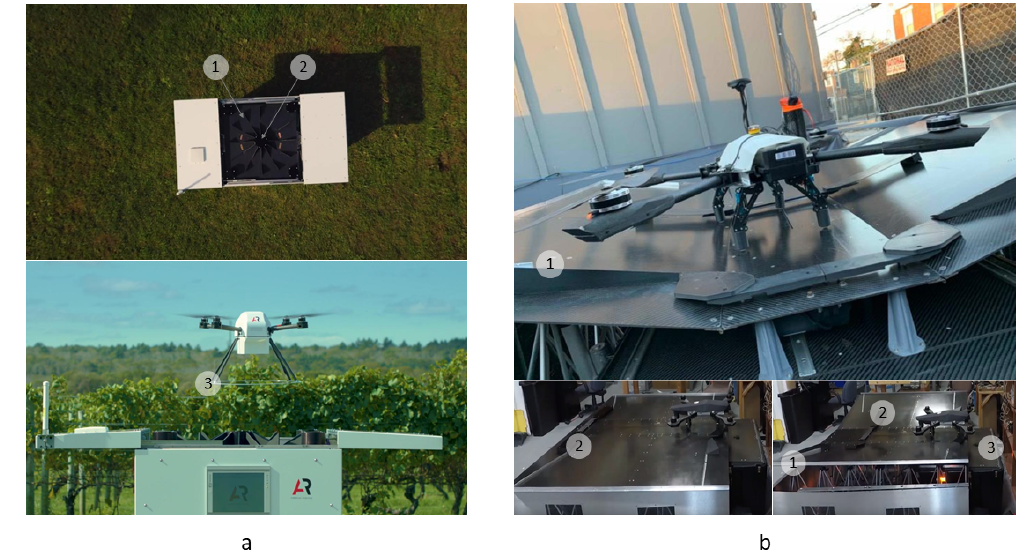
Figure 31. Examples of commercially available landing platforms. ( a ), Scoutbase by American Robotics, Inc. [81], landing platform with a conical funnel 1 and a protruding cone at center 2 for a UAV with a circle on the legs 3; ( b ), DroneCore by Asylon [82], a hybrid of passive and active positioning.